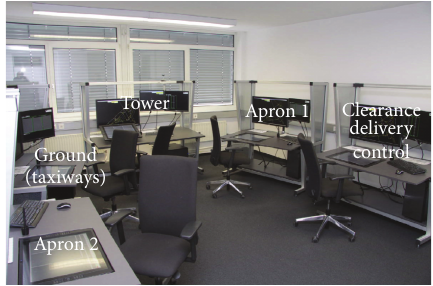
Figure 10: Control room of the Hamburg Airport human-in-the- loop simulation exercise. Each controller workstation is labeled with the controller’s function in the experiment.